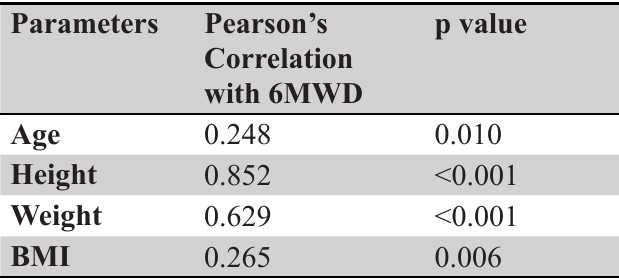
Table 2: Correlation of 6MWD with different parameters in combined participants.